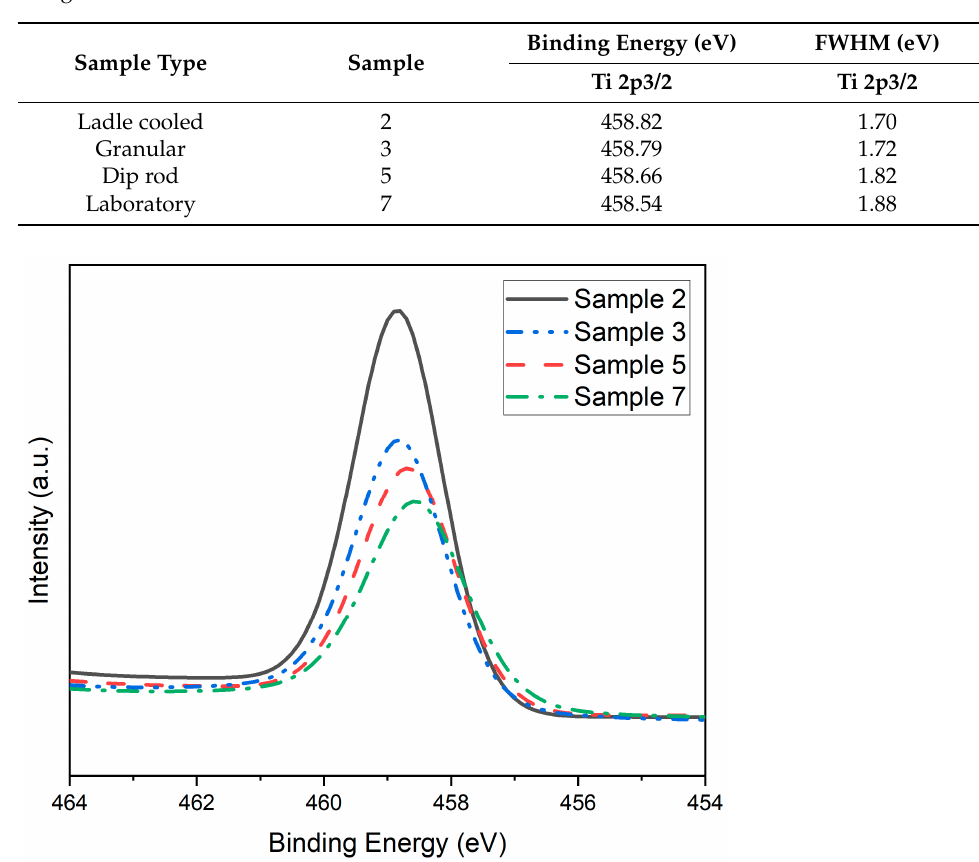
Table 5. Binding energies and Full Width Half Maximum (FWHM) of different slag samples calculated using XPS.